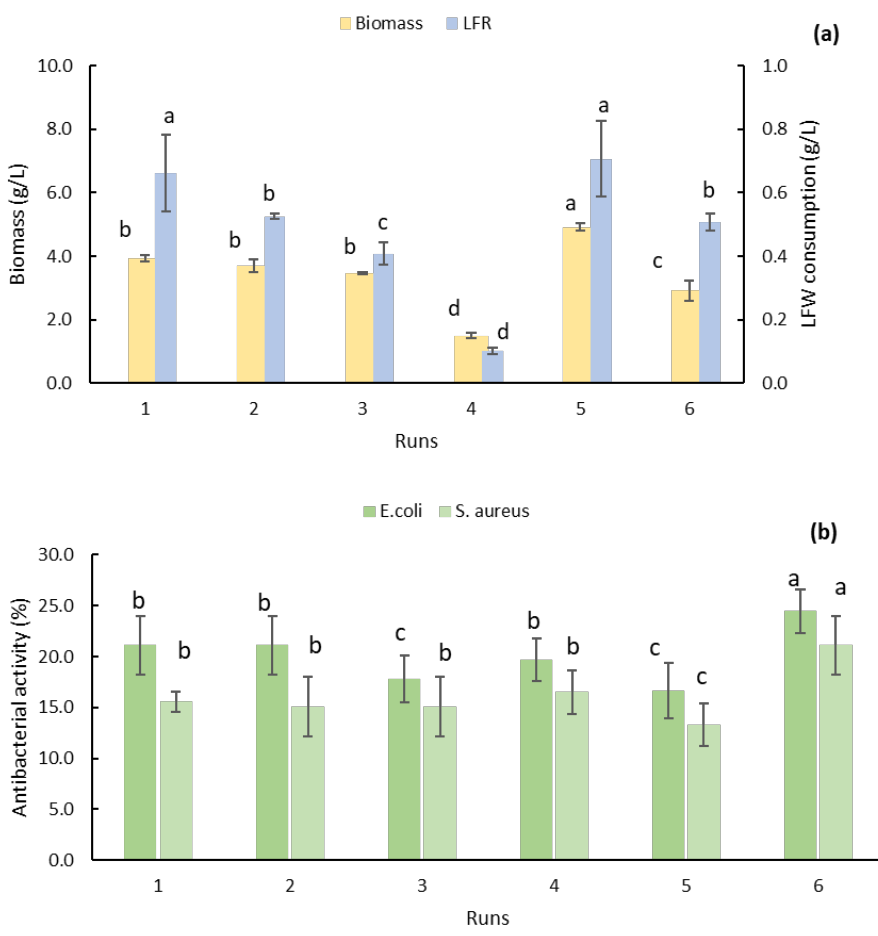
Figure 2. Effect of LFR and yeast extract concentration on biomass concentration and LFR consumption ( a ) and antibacterial activity ( b ) in cultures of R. rubra . Symbols indicate statistical differences ( p < 0.05).